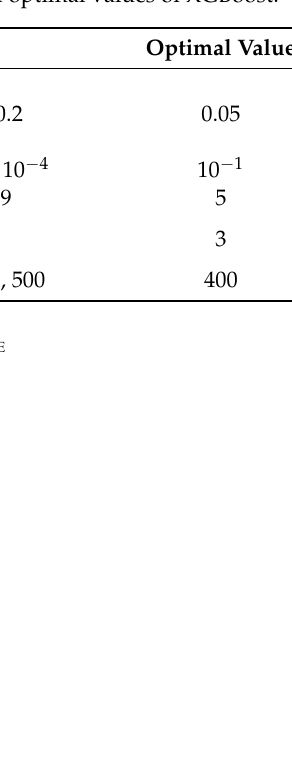
Figure 10. Hyperparameter optimization process for XGBoost.